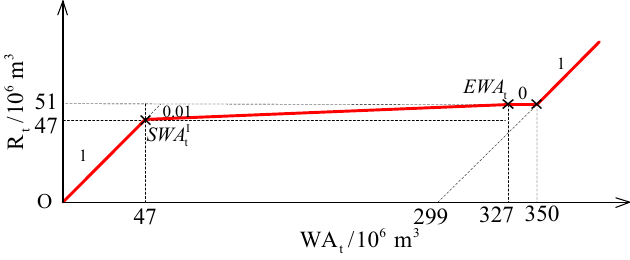
Figure 13. The operation policy in July obtained using Shiau’s method.